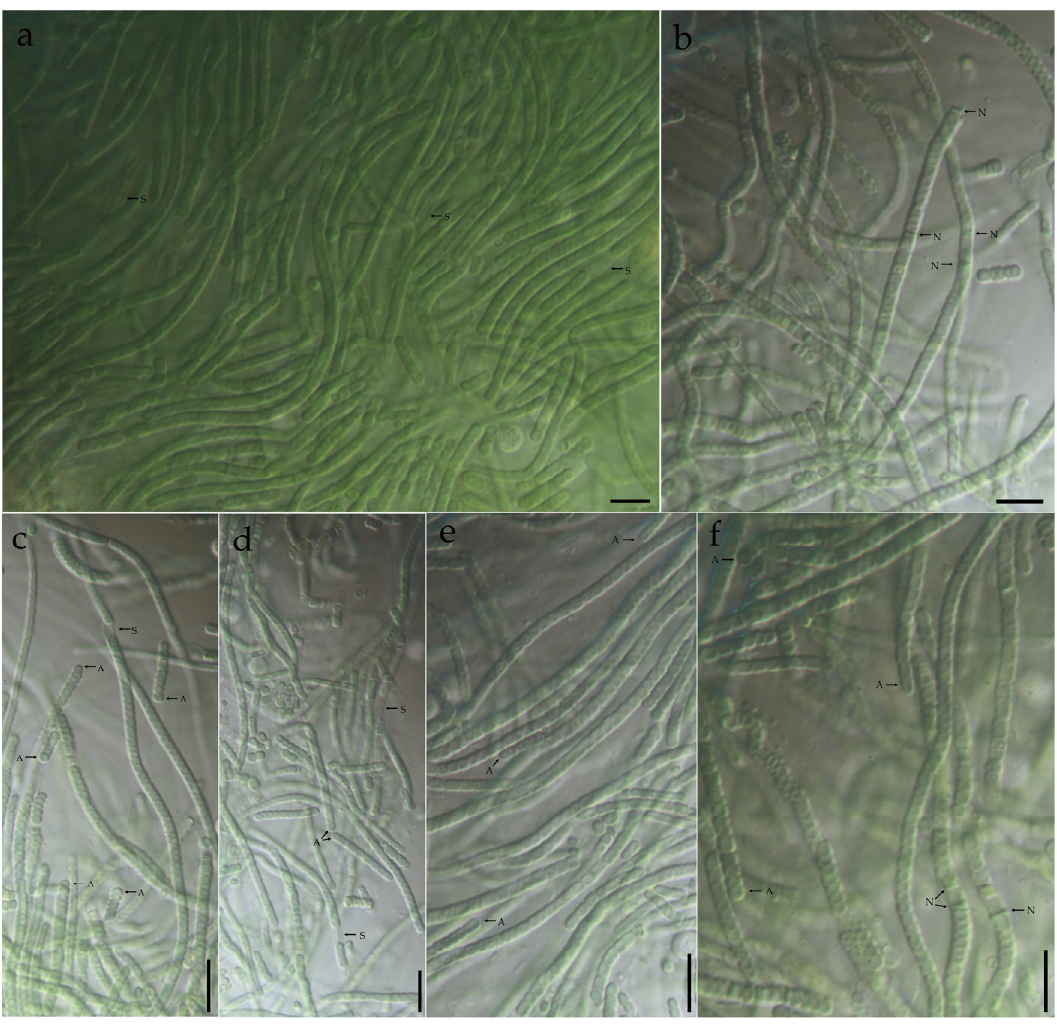
Figure 3. Light micrographs of Stenomitos nagquensis sp. nov . from the strain CSML-F035: ( a ) Parallel trichomes; isodiametric cells. ( b – f ) Detail of trichomes with varying shapes of apical cells; some trichomes also showing clear constrictions at the cross-walls. (S) Sheaths; (N) necridia; (A) apical cells; scale bar: 10 µm.